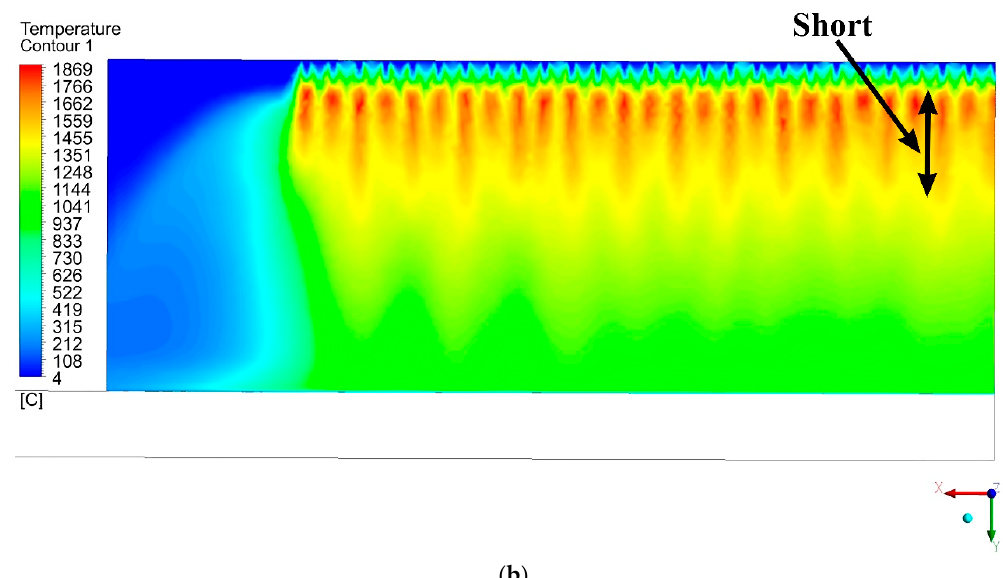
Figure 12. The temperature contours of a combustion flame zone at the center-line view during the steel-plate preheating process: ( a ) basic model; ( b ) modified model.